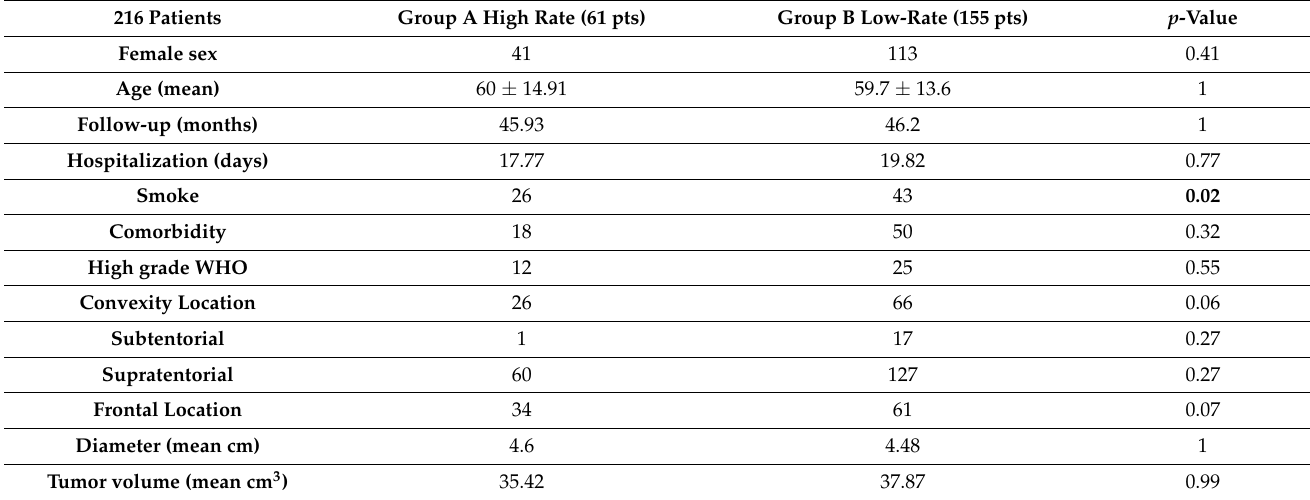
Table 1. Analysis of